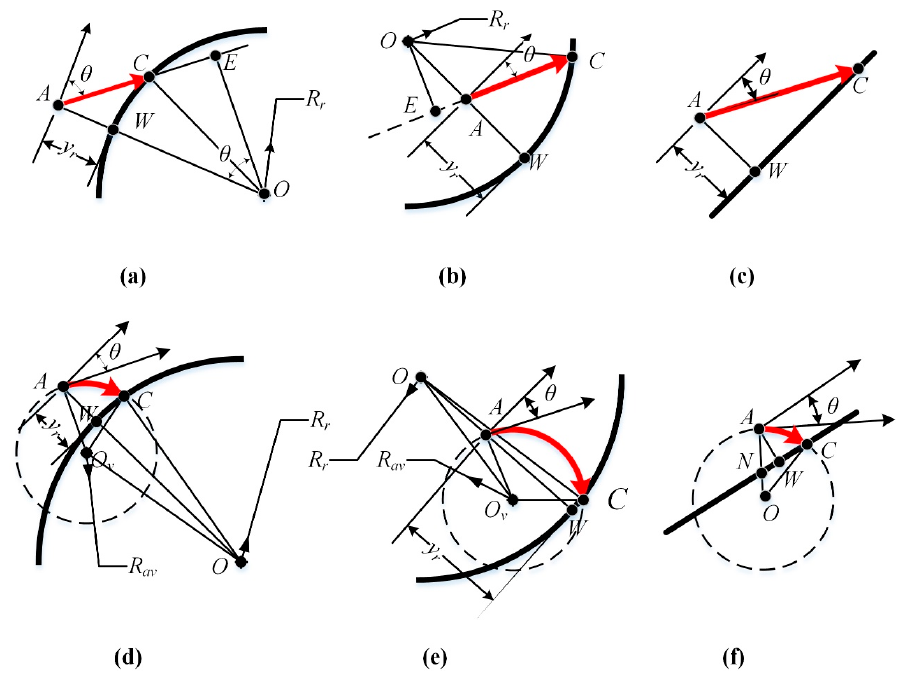
Figure 6. Calculation of the deviation length ( DL ) with combinations of the boundary and Turning behavior. ( a ) the ship Runs near the convex boundary; ( b ) the ship Runs near the concave boundary; ( c ) the ship Runs near the straight boundary; ( d ) the ship has Turn to Starboard / Turn to Port behavior near the convex boundary; ( e ) the ship has Turn to Starboard / Turn to Port behavior near the concave boundary; ( f ) the ship has Turn to Starboard / Turn to Port behavior near the straight boundary.